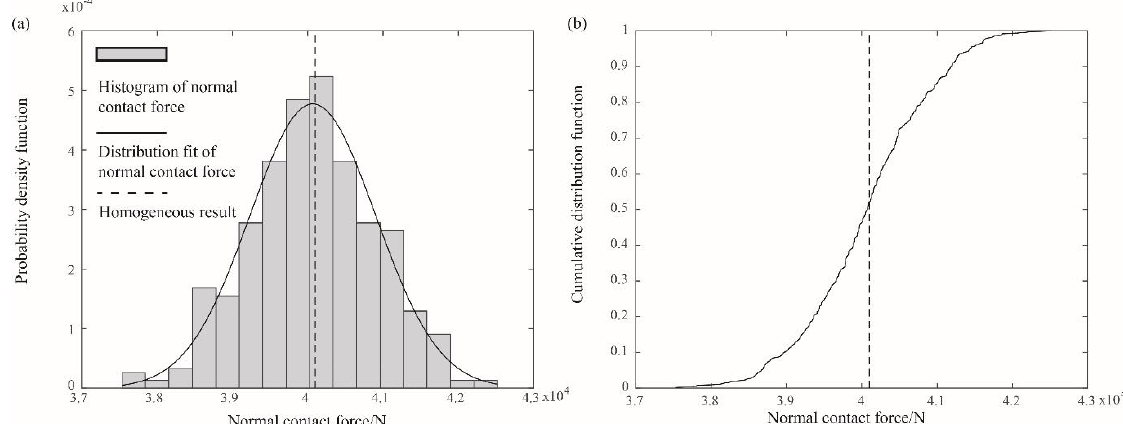
Figure 9. Probability density function (PDF) ( a ) and cumulative distribution function (CDF) ( b ) of the normal contact force at the middle bottom point A of the elastic block from 500 realisations when the coefficient of friction is 0.